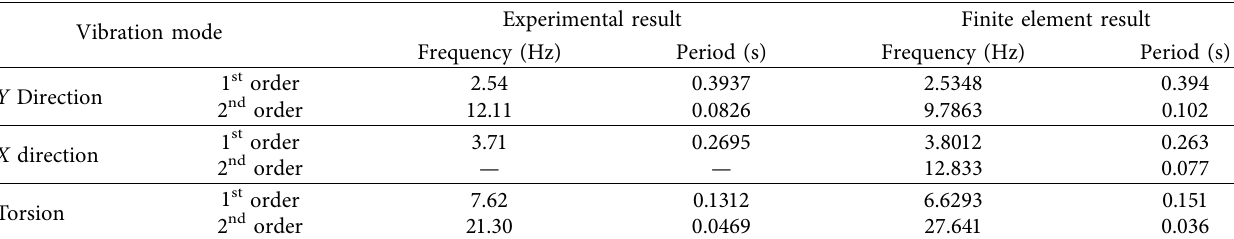
Table 11: Comparison of free vibration characteristics. Vibration